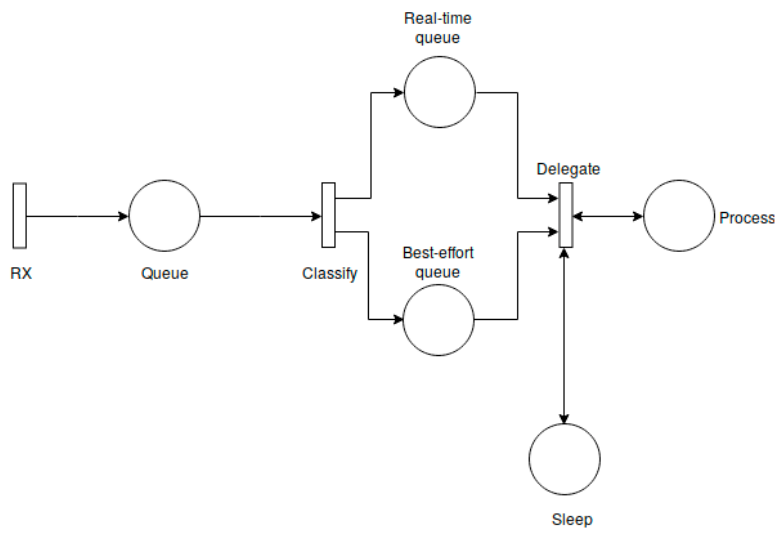
Figure 3. SPN power consumption model for sensor anomaly detection.